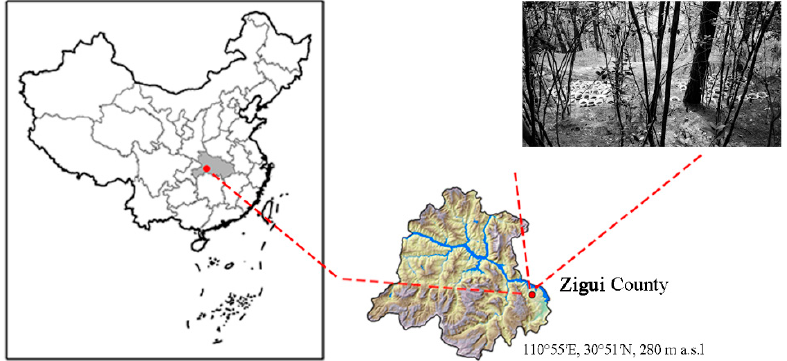
Figure 1. Study region in the Three Gorges Reservoir area of China and the experimental layout showing the litter bag distribution in the selected Masson pine ( Pinus massoniana Lamb.)